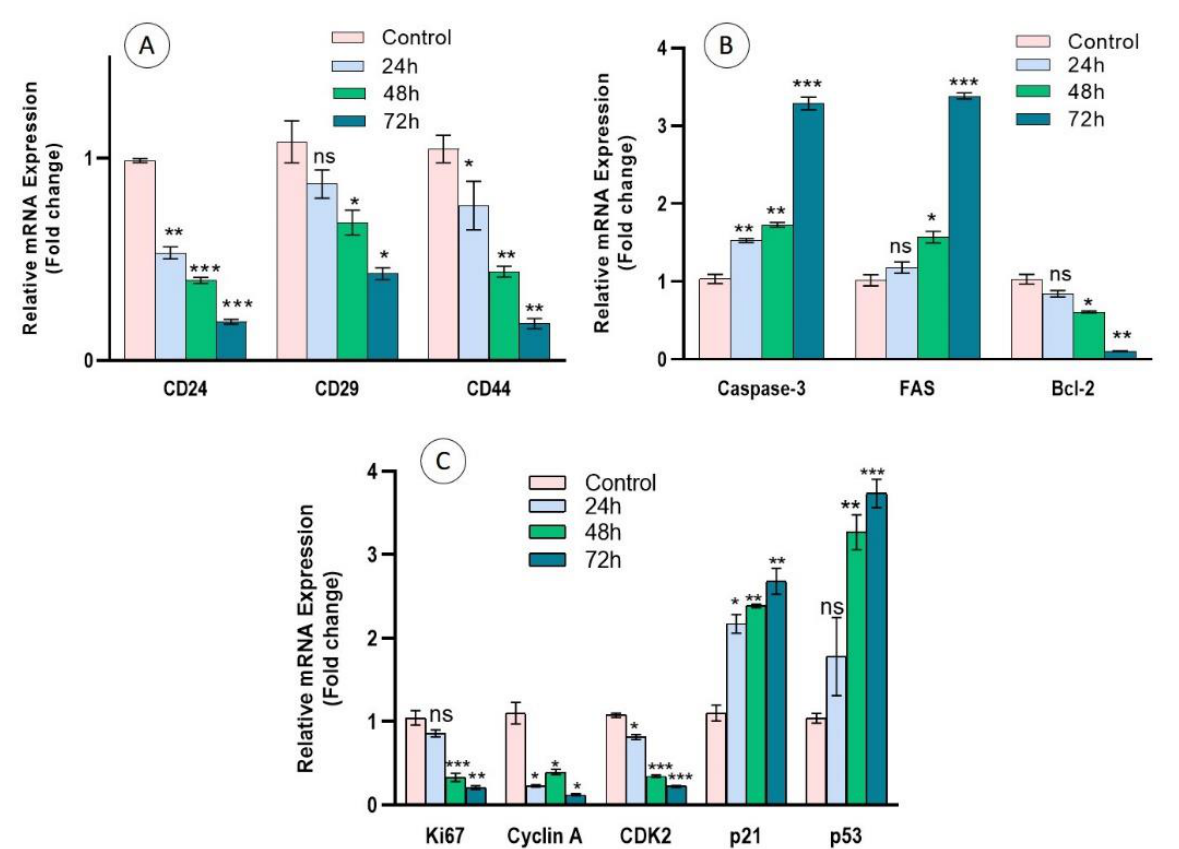
Figure 6. ( A ) Expression of the cell surface markers CD24, CD29, and CD44 was significantly down- regulated in MCF7 cells treated with C. colocynthis silver nanoparticles (Cc-AgNPs). ( B ) Expression of the pro-apoptotic genes caspase-3 and FAS was upregulated, while the anti-apoptotic gene Bcl-2 showed considerable downregulation. ( C ) Expression of the proliferation marker Ki67, cyclin A, and CDK2 was downregulated, whereas expression of the cyclin/CDK inhibitor p21 and its transcriptional activator p53 was upregulated in time-dependent manner. (* p < 0.05, ** p < 0.01, *** p < 0.001). Cc-AgNP-treated cells showed a significant decrease in the intracellular cholesterol concentration at 72 h compared with the control. Similarly, the concentration of triglyc- erides was also significantly decreased at 72 h (Figure 7A). The expression analysis of genes involved in lipid metabolism, FASN, HMGCLL1, ELOVL6, and ACSL1, further strengthened the antilipidemic effect of Cc-AgNPs. Maximum downregulation was shown by HMGCLL1 after 72 h of treatment. FASN was also significantly downregulated at 48 and 72 h. ELOVL6 was also downregulated, with maximum downregulation at 72 h. ACSL-1 showed a significant decrease in expression until 48 h and then increased at 72 h (Figure